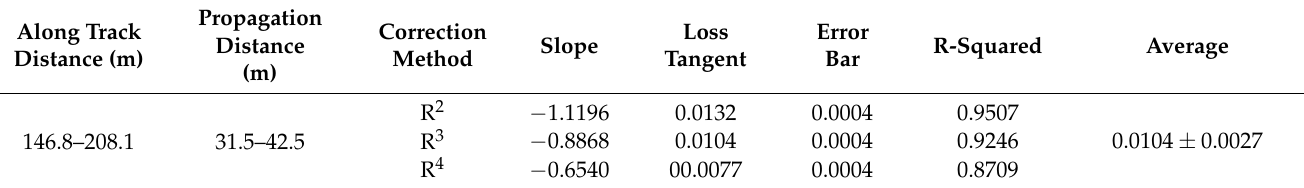
Table 3. The attenuation estimated result of adjacent 1700 tracks of LPR